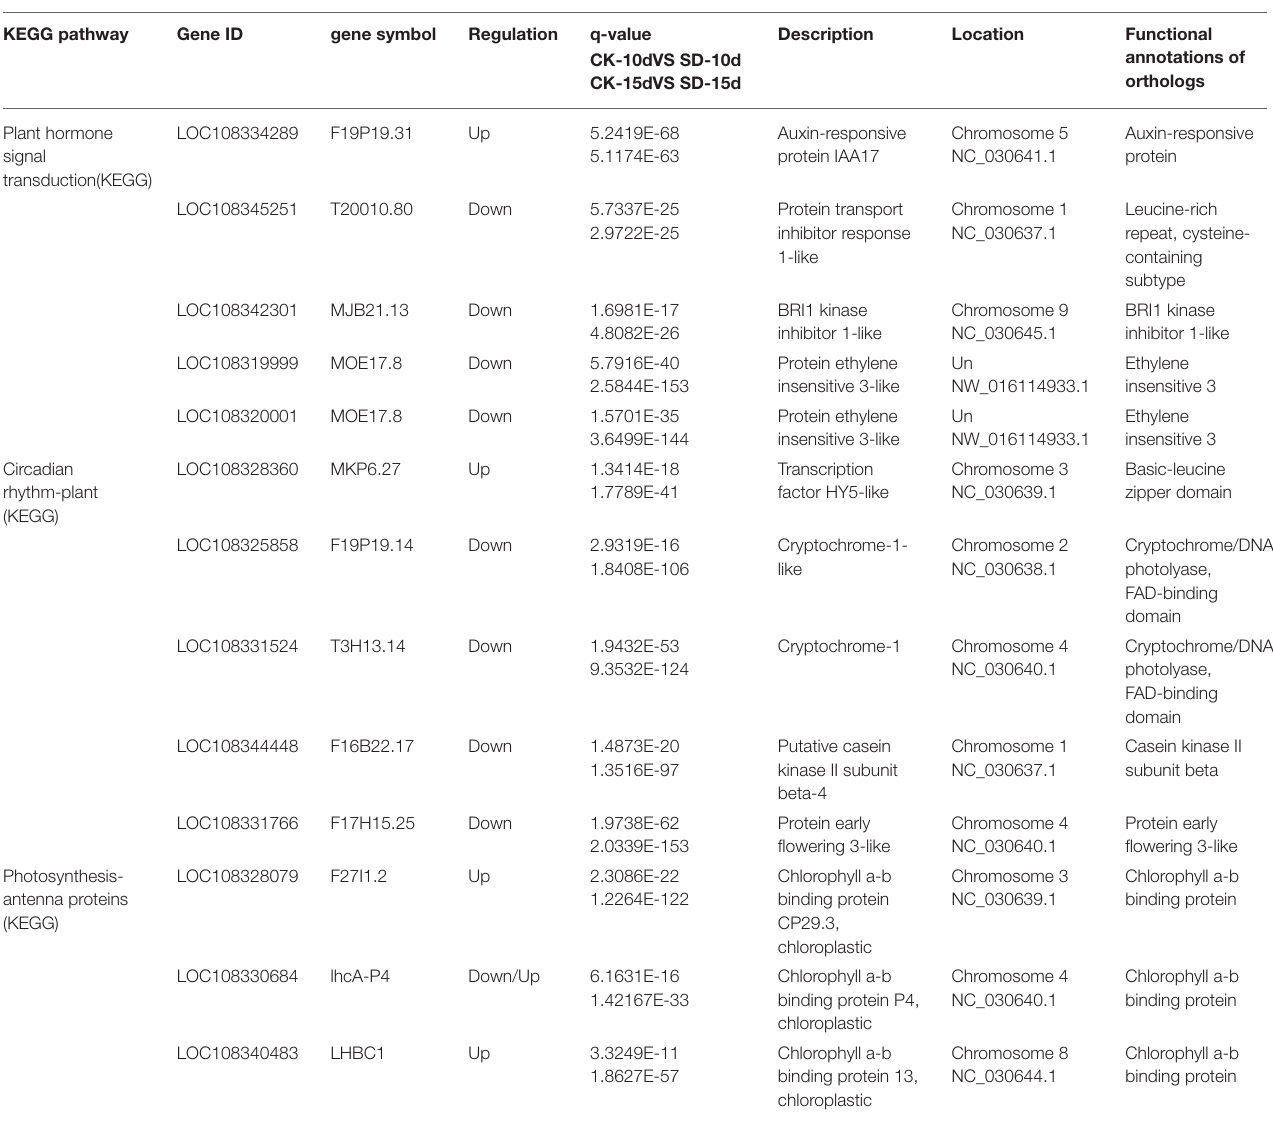
TABLE 5 | List of different genes associated with light exposure in different signaling pathways. KEGG